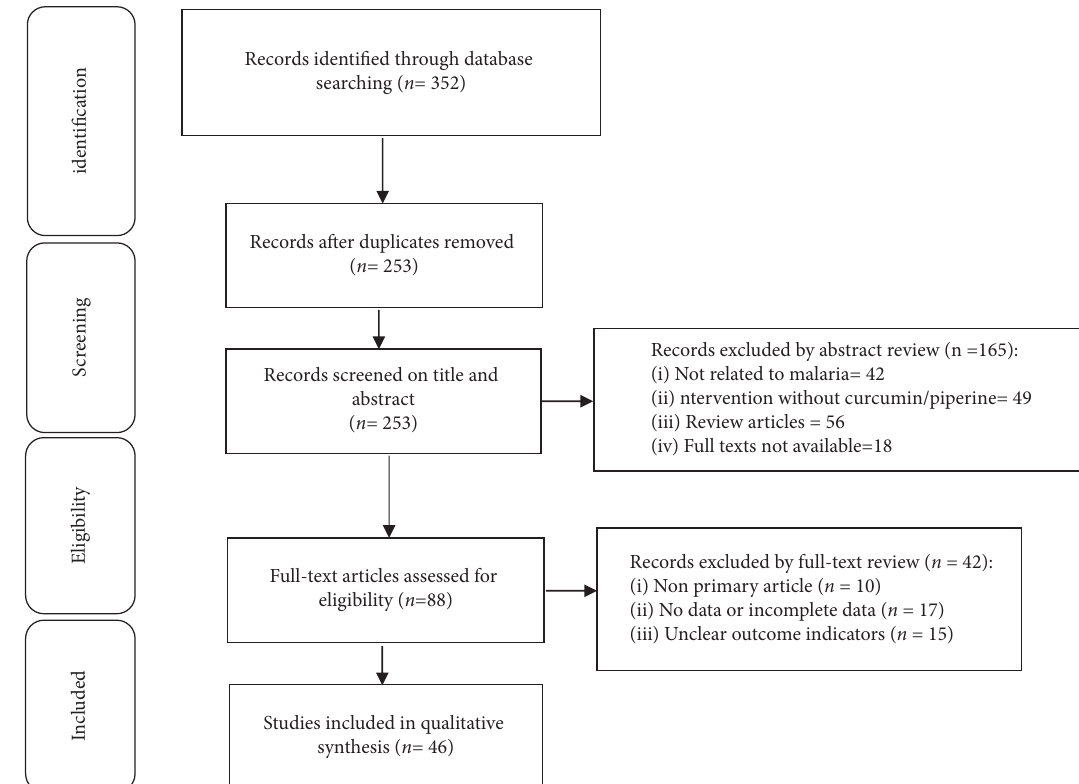
Figure 1: Flow chart of literature